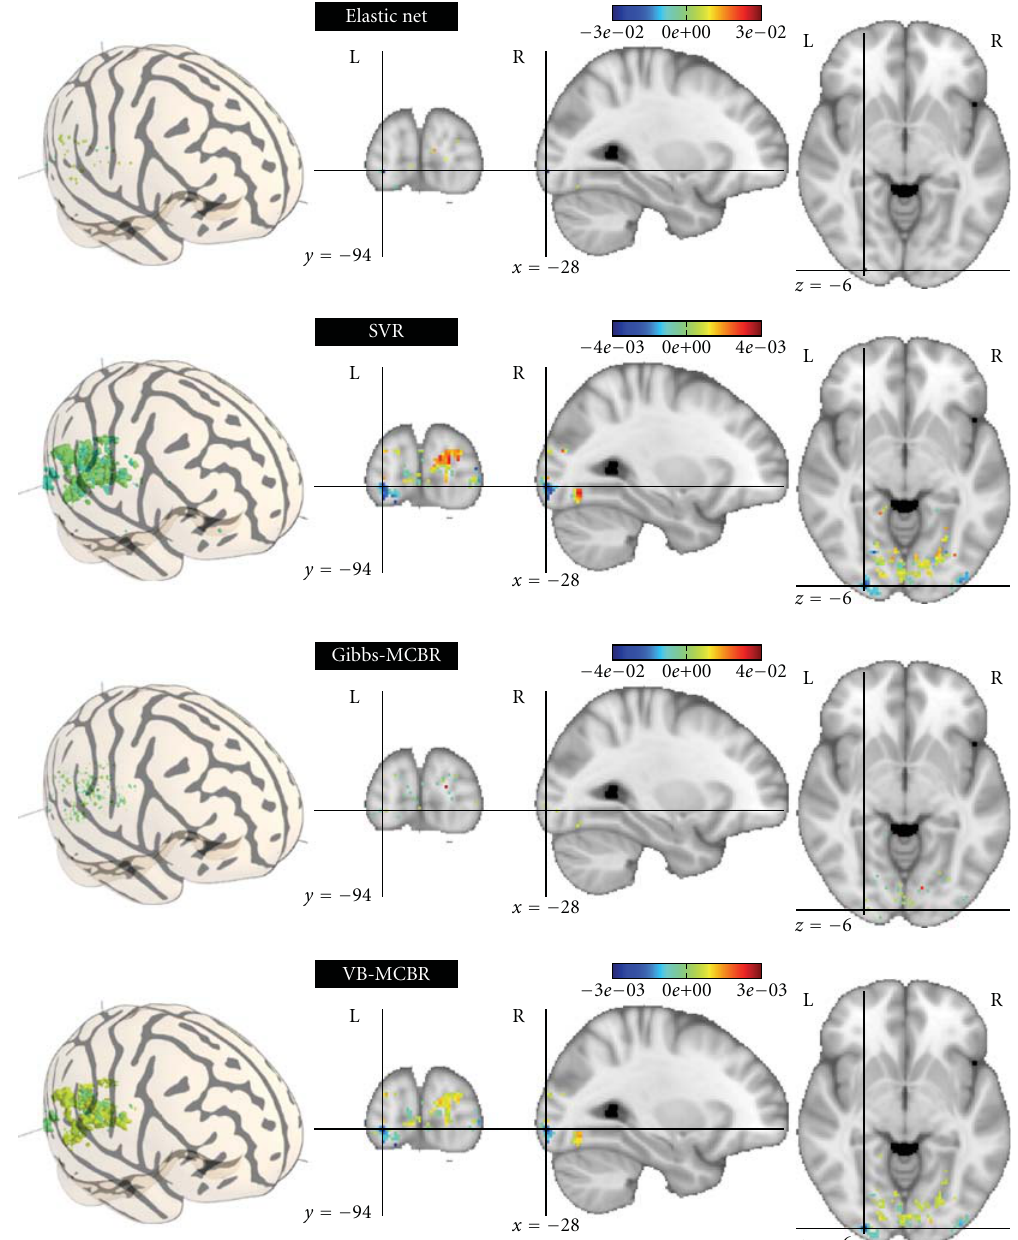
Figure 6: Intersubject analysis . Maps of weights found by the di ff erent methods on the 2500 most relevant features by Anova. The map found by elastic net is di ffi cult to interpret as the very few relevant features are scattered within the whole brain. SVR and VB-MCBR do not yield a sparse solution. Gibbs-MCBR, by performing an adaptive regularization, draws a compromise between the other approaches and yields a sparse solution, but also extracts small groups of relevant